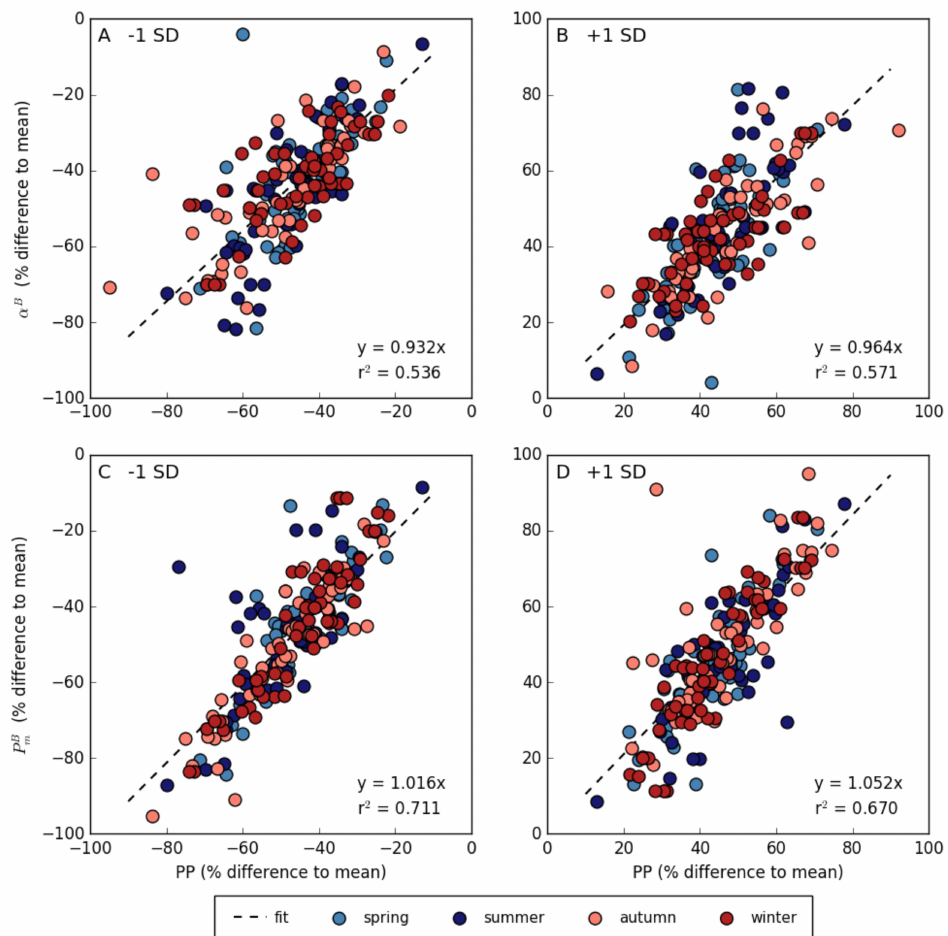
Figure 6. Relationship between photosynthesis versus irradiance (P-I) parameters and primary production (PP) expressed as percentage difference in ( A , B ) the initial slope ( α B ) and ( C , D ) the assimilation number ( P B m ) of the P-I curve and primary production for –1 standard deviation (–1 SD) ( A , C ) and +1 standard deviation (+1 SD) ( B , D ) compared with mean P-I parameters estimates. Each point represents a biogeographical province and season for the period between 1998 and